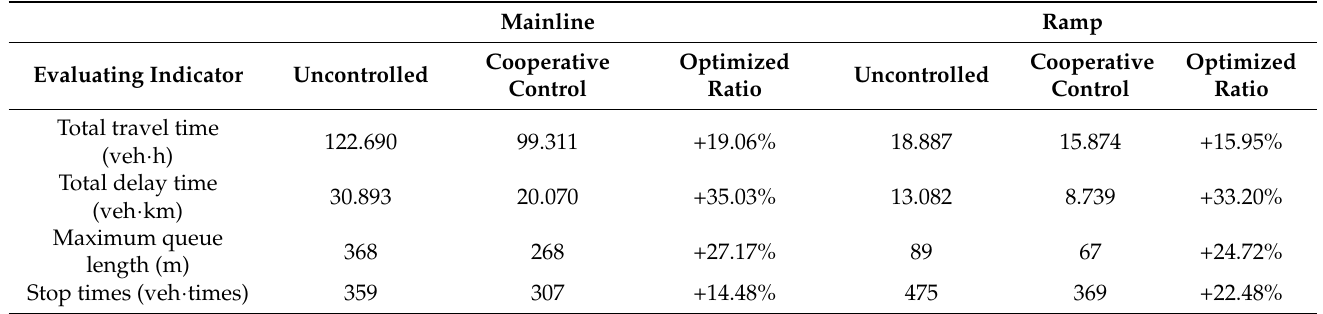
Table 8. Comparison of operation efficiency before and after control of merging area